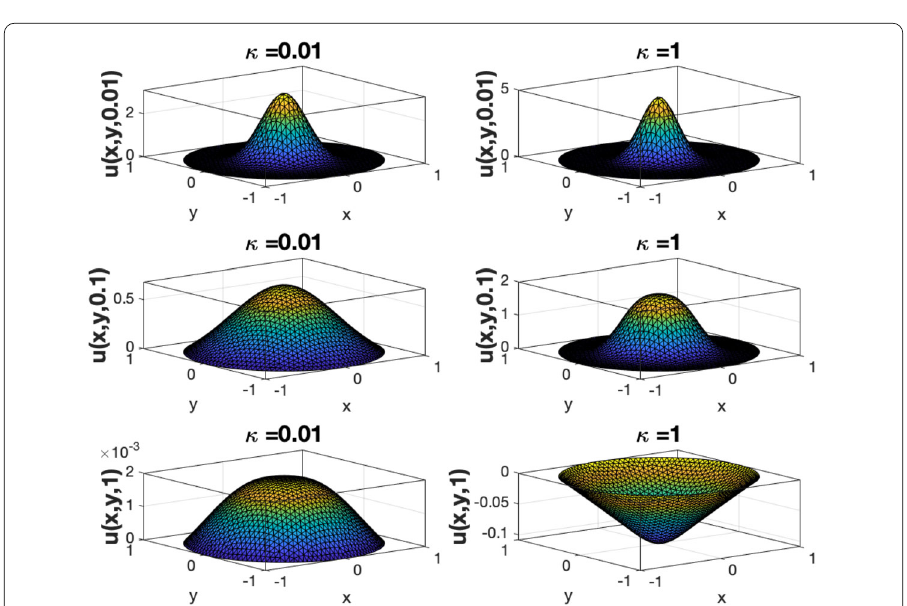
Figure 1 Comparison behavior of u ( x , y ,0.01), u ( x , y ,0.1) and u ( x , y ,1) for (1.1) with fixed α = 1.5 and different κ , computed by SBD scheme with h = 0.05, N =